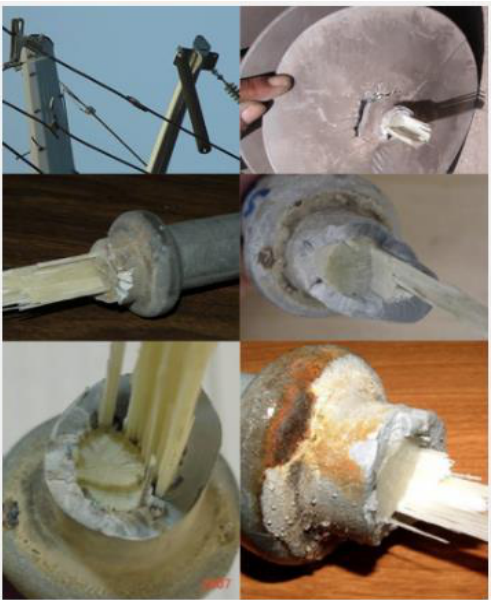
Figure 1. Illustrations of the damage, degradation and aging of polymeric insulators [11]. Table 1. List of the various types of failures of polymeric insulators identified by EPRI [7]. Failure Type % of Failure Recorded (221) Brittle fracture 51.1% Flashunder 24.9% Mechanical failure: rod failure Rod destruction by discharge activity